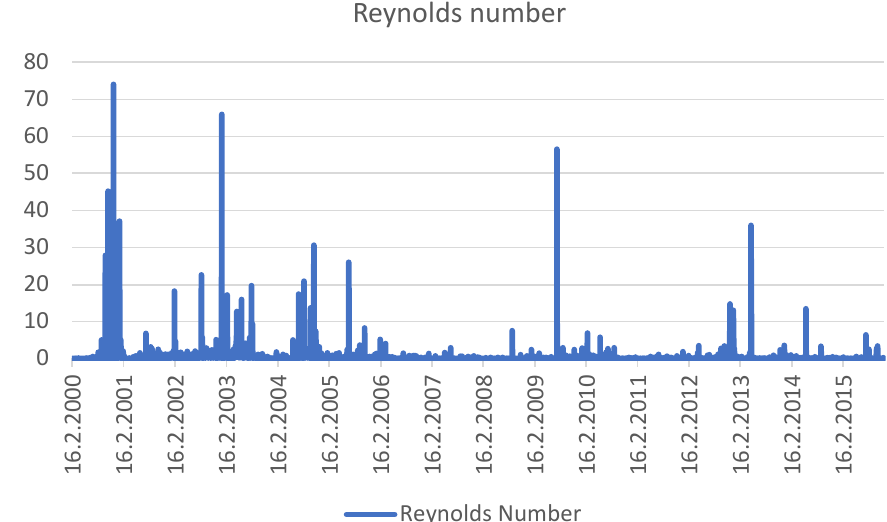
Figure 1. The Reynolds number over a period of 16 years, clearly coming down in amplitude and